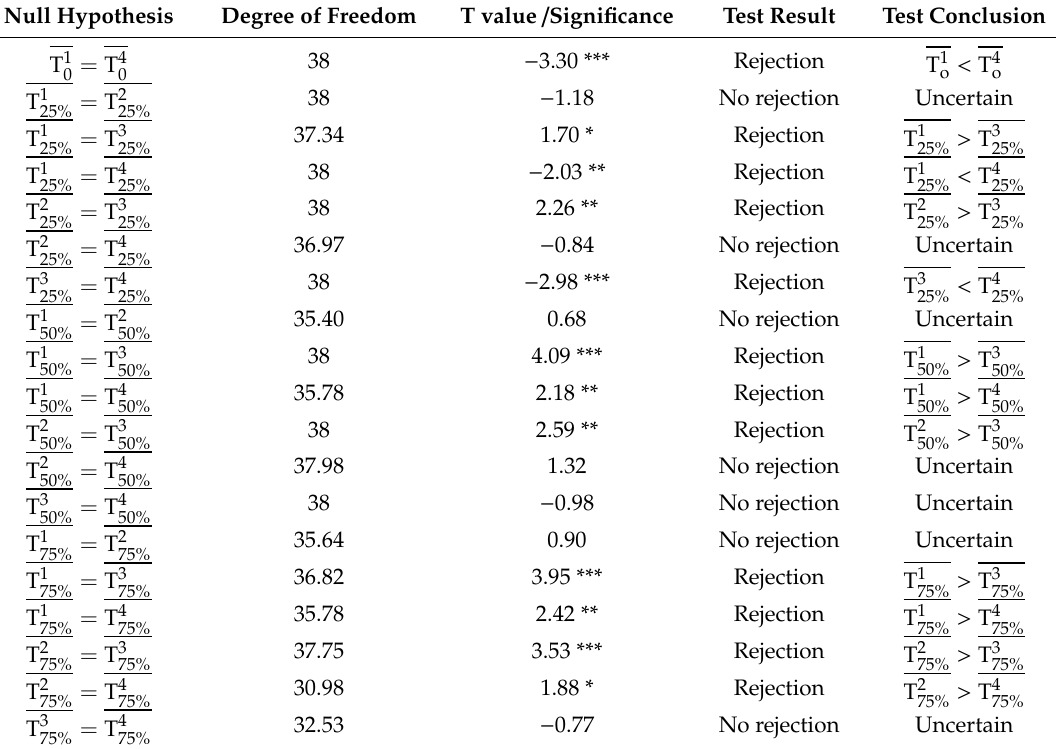
Table 9. Hypothesis test